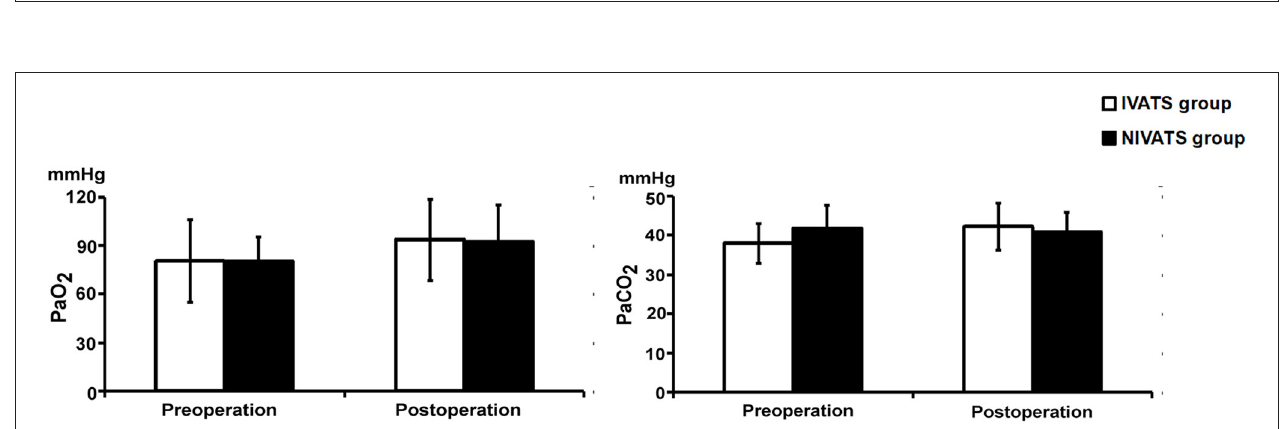
FIGURE 2 | Blood cells analysis (the left is leukocyte and the right is neutrophil ratio) in the IVATS group and NIVATS group before and after the operation. * P -value presents the comparison of values between IVATS and NIVATS group (*presented P < 0.05 and **presented P < 0.01) # P -value presents the comparison of preoperative and postoperative values in the IVATS group ( # presented P < 0.05 and ## presented P < 0.01).